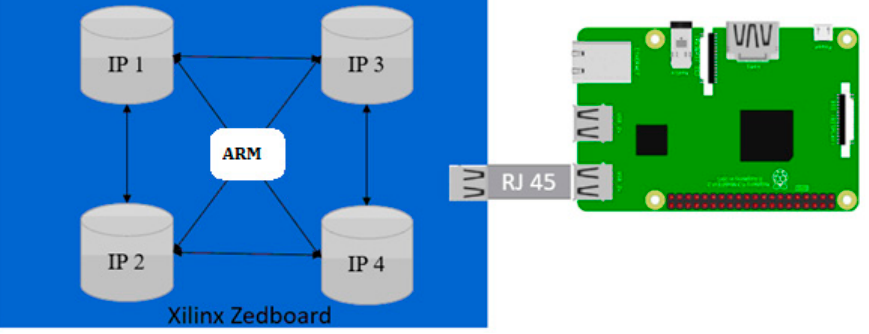
Figure 7. The proposed Intranet architecture.